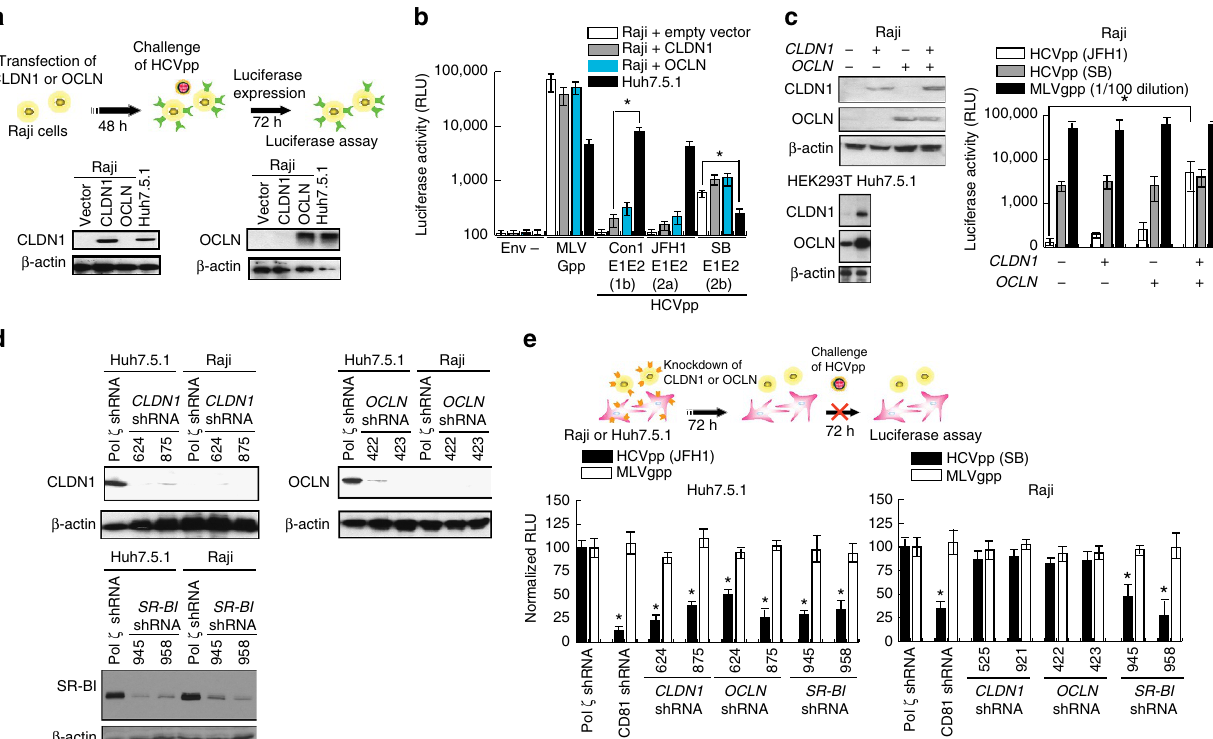
Figure 4 | HCV pseudo-particles (HCVpp) with envelope proteins of SB strain infected B lymphocytes, but not hepatic cells. ( a ) Claudin1 (CLDN1) or Occuludin (OCLN) expression confers weak susceptibility of Raji cells to JFH1 infection (Upper panel). Immunoblot analysis demonstrated that Claudin-1 and Occludin proteins were expressed by transfection of plasmids. ( b ) The respective expression vectors of CLDN1 and OCLN were transfected into both Raji and Huh7.5.1 cells. Luciferase-encoding pseudo-particles bearing the indicated envelope proteins were used to infect recipient Raji cells transfected with control vector (white), CLDN1-expressing vector (grey), or OCLN-expressing vector, or control Huh7.5.1 cells (black). For HCVpp, the respective E1E2 genes are indicated in parentheses. Luciferase assay was performed at 3 days after transduction (* P o 0.05, t -test). Values are normalized to the RLU background measured in mock-infected cells (mean of n ¼ 3; error bars, s.d.). RLU: relative luminescence units. ( c ) The respective expression vectors of CLDN1 and OCLN were transfected and their protein expression levels were confirmed in both Raji and Huh7.5.1 cells. ( Left panel ) Expression of both CLDN1 and OCLN (tight junction molecules) promoted HCVpp(SB) entry (right panel) (* P o 0.05, t -test, n ¼ 3). Error bars represent s.d. ( d ) Cells were transfected to express shRNA against CLDN1 or OCLN and examined for silencing effects by immunoblots. shRNAs against DNA polymerase z (an irrelevant shRNA for HCVentry) were used as the negative and positive controls, respectively. Two different shRNA clones targeting either CLDN1 or OCLN were used. ( e ) Silencing of tight junction molecules CLDN1 and OCLN did not inhibit HCVpp(SB) entry in lymphocytes while expression of CLDN1 and OCLN is required for the susceptibility to HCVpp(JFH1) in hepatocytes. Cells were challenged with HCVpp (black bars: pseudotyped with SB or JFH1 E1E2) or MLV-Gpp (white bars) encoding a luciferase reporter (* P o 0.05, t -test, n ¼ 3). Error bars represent